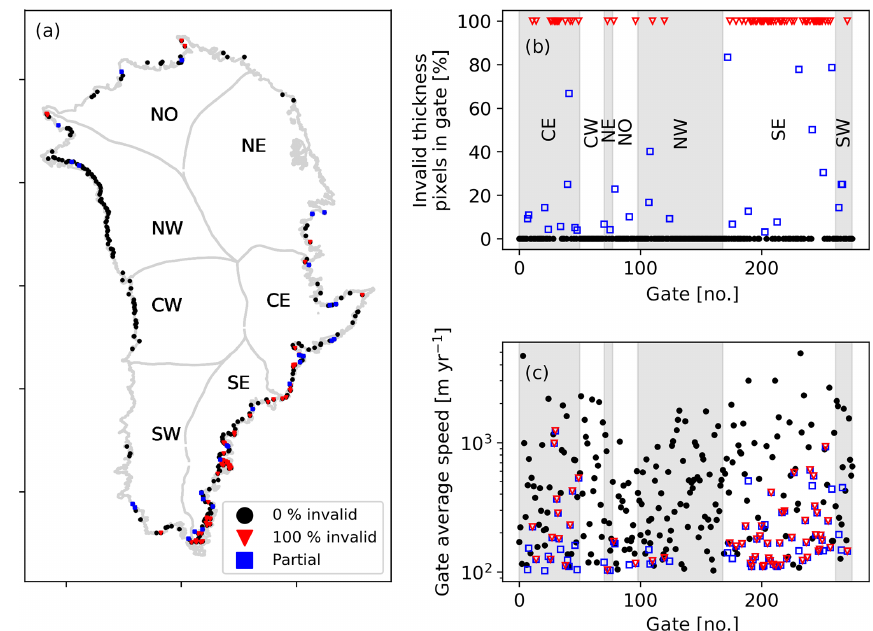
Figure A1. Gate locations and thickness quality. (a) Locations of all gates. Black dots represent gates with 100% valid thickness pixels, blue with partial, and red with none. (b) Percent of bad pixels in each of the 267 gates, arranged by region. (c) Average speed of gates. Color same as left panel.